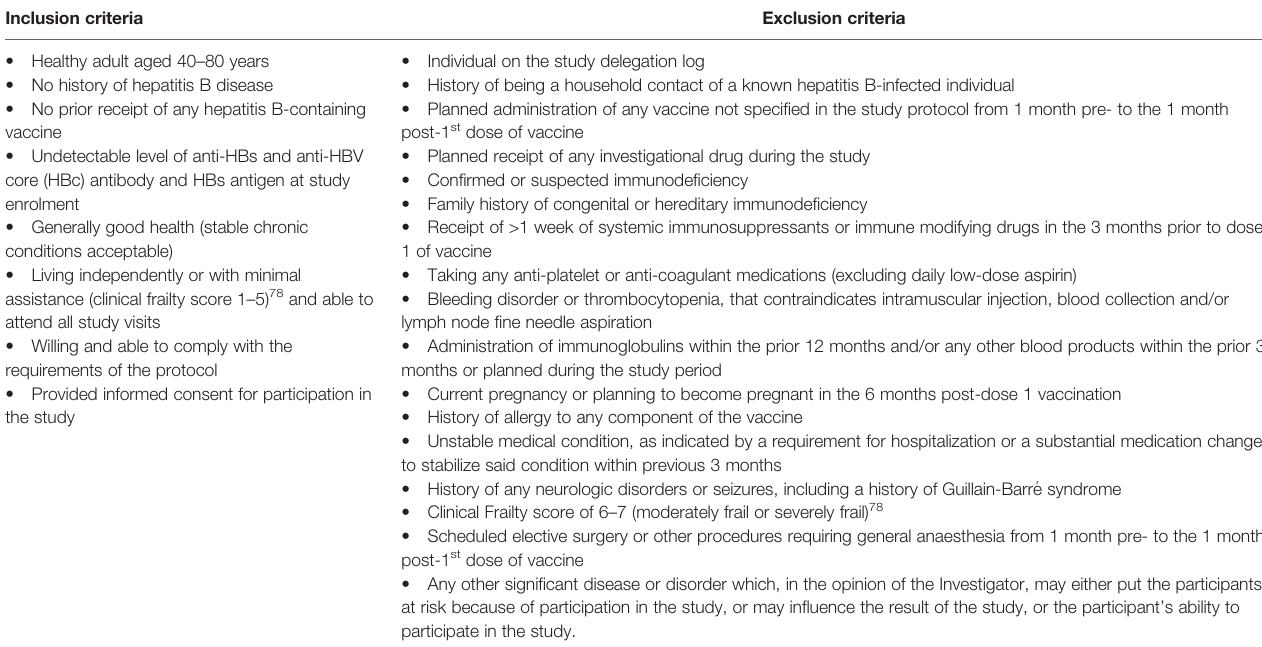
TABLE 1 | Study inclusion and exclusion